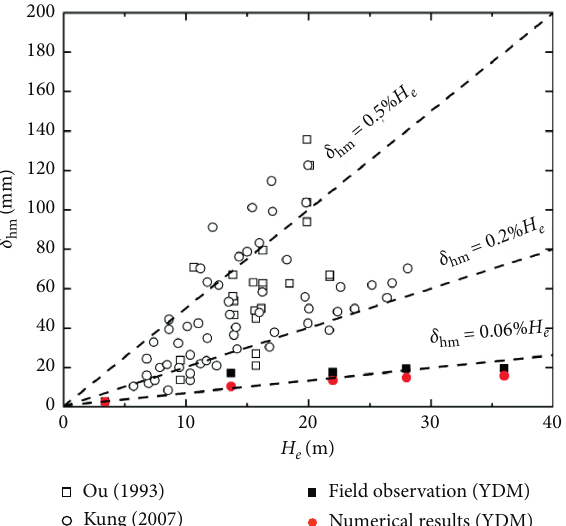
Figure 12: He versus δ